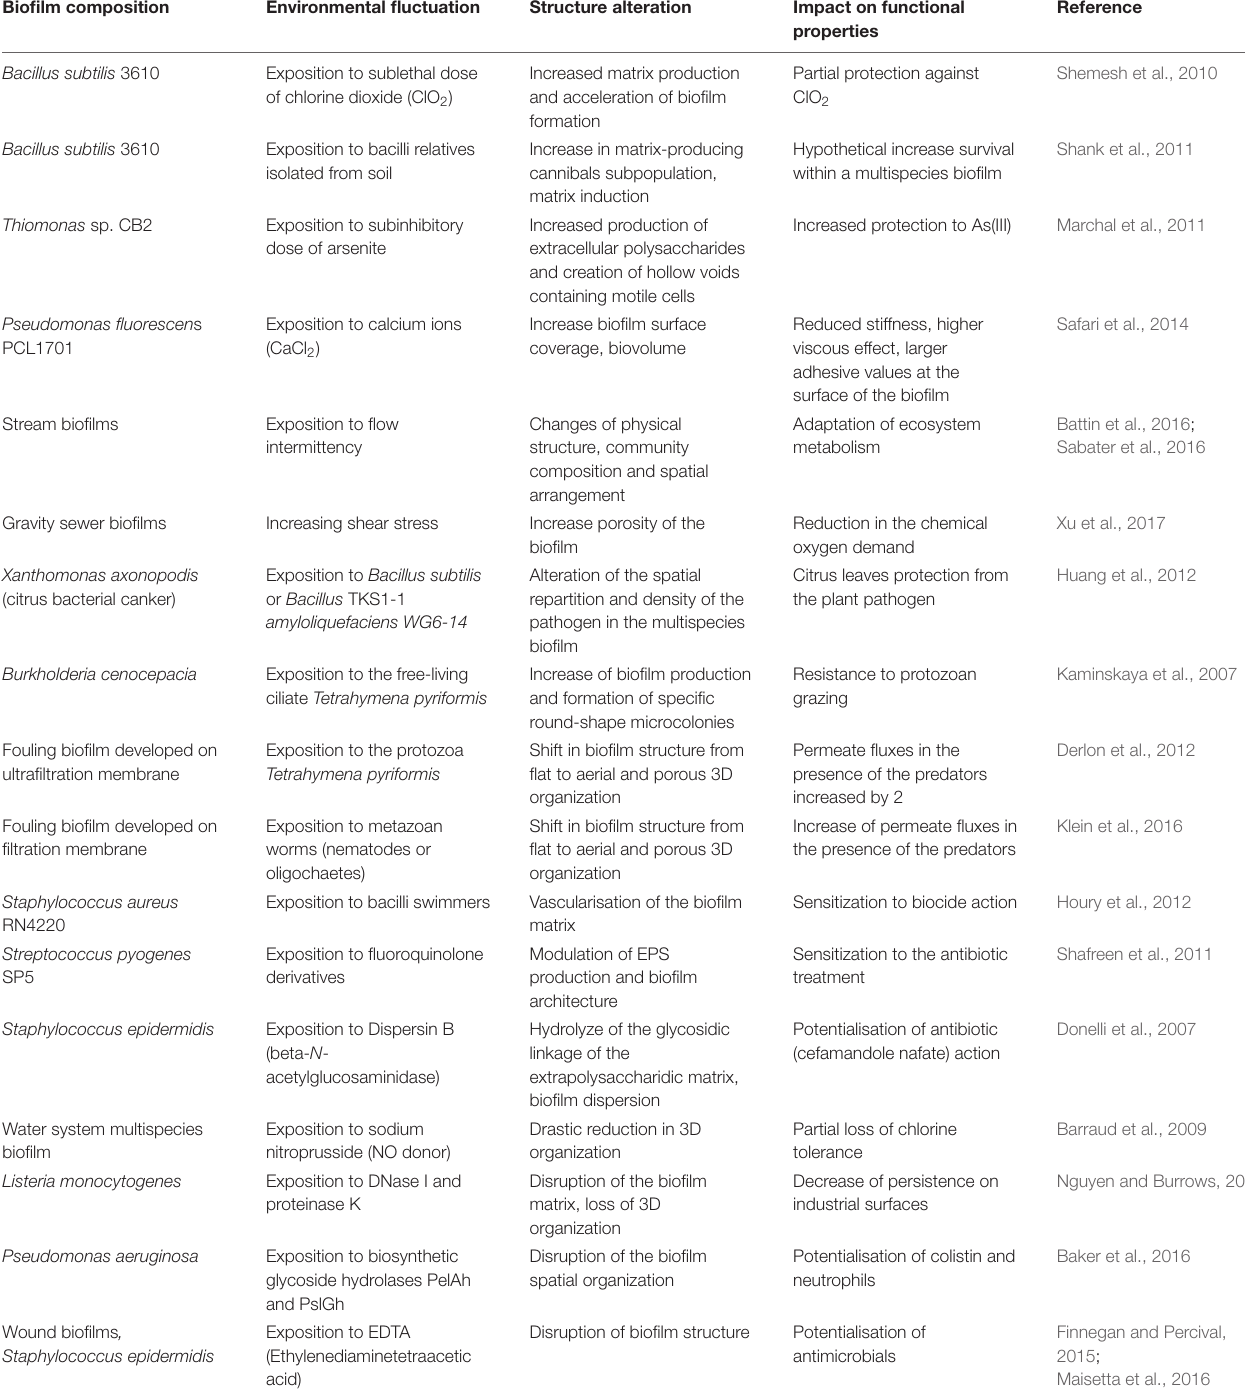
TABLE 1 | Examples of biofilm structural responses to environmental fluctuations associated with the alteration of community